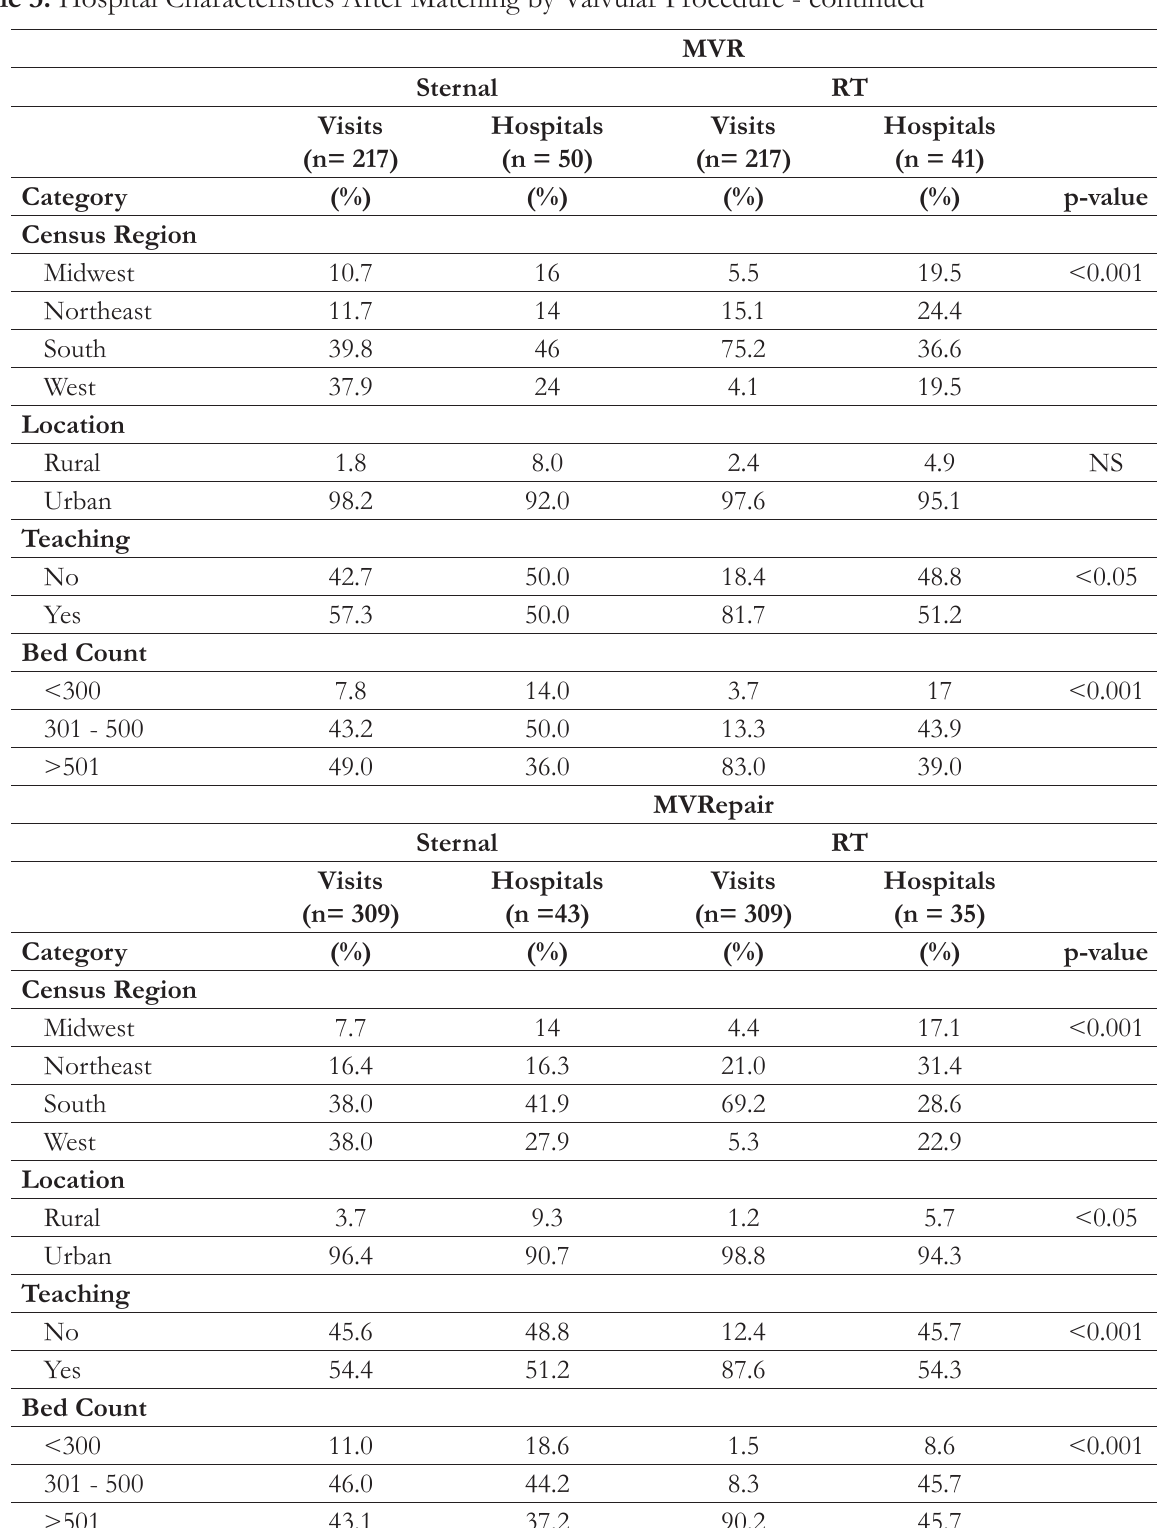
Table 3. Hospital Characteristics After Matching by Valvular Procedure -